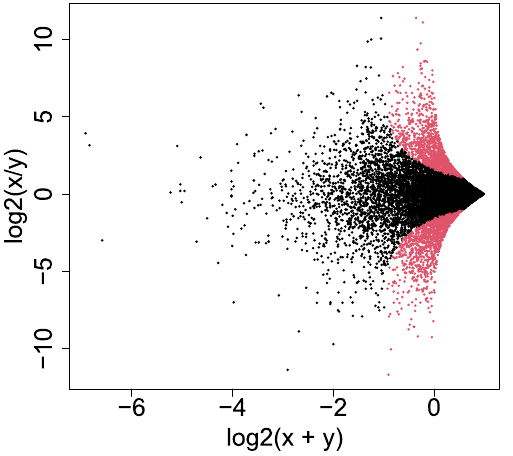
Figure 16. “MAPlot” using two independent variables, x and y , drawn from uniform distribution ∈ [ 0, 1 ] . Red dots are associated with | x − y | > 0.5